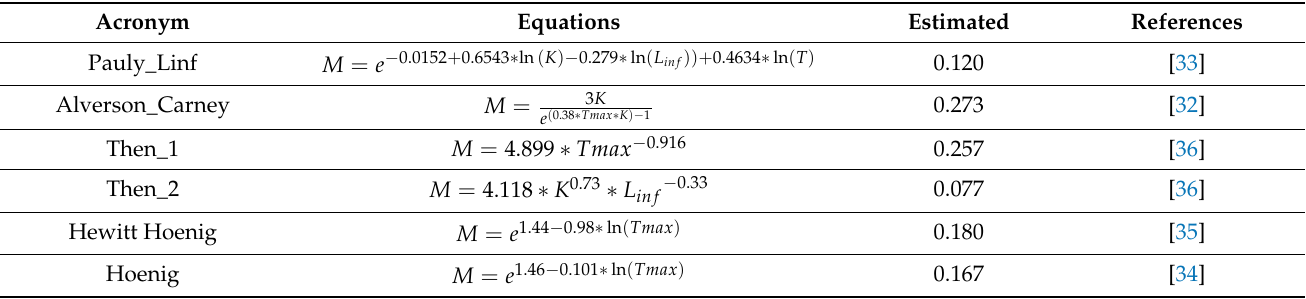
Table 2. Natural mortality ( M ) methods and equations used. The parameters L inf and K are obtained from the von Bertalanffy growth function, Tmax is the maximum observed age, reported Tmax for silky shark is 25 years (FishBase, [46]), and T is the temperature ( ◦ C). In this study the temperature was assumed as T = 19 ◦